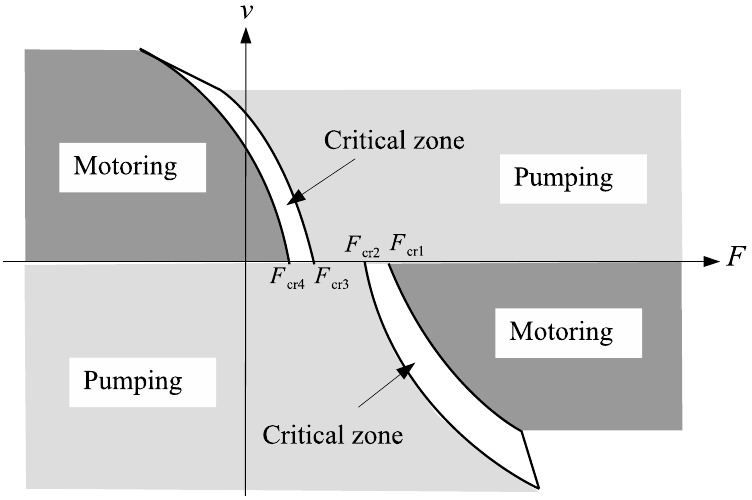
Figure 11. Critical zones and quadrant division [14].